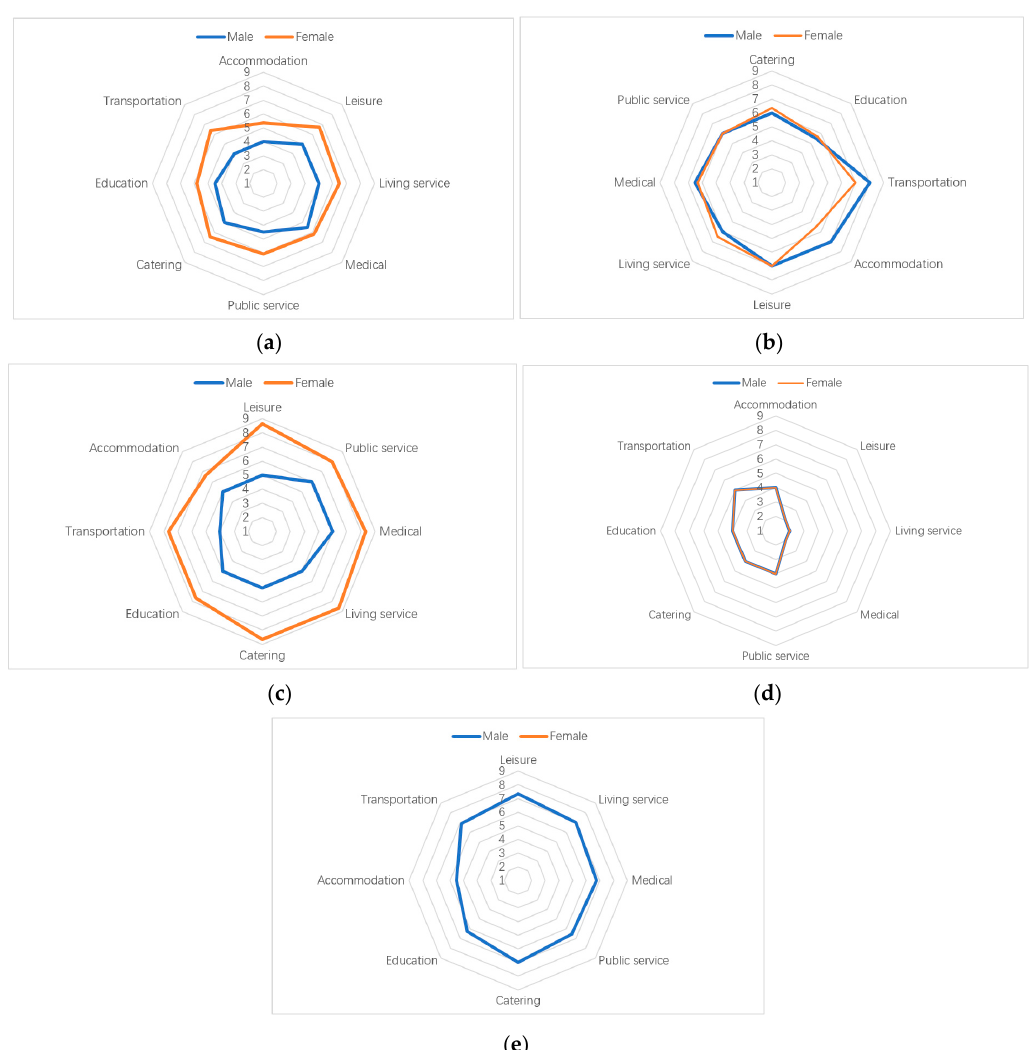
Figure 12. POI characteristics for different types of lakes among male users: ( a ) The POI grades of the evening peak lakes; ( b ) the POI grades of the morning peak lakes; ( c ) the POI grades of the morning and evening double-peak lakes; ( d ) the POI grades of the noon peak lakes; ( e ) the POI grades of the stable lakes.